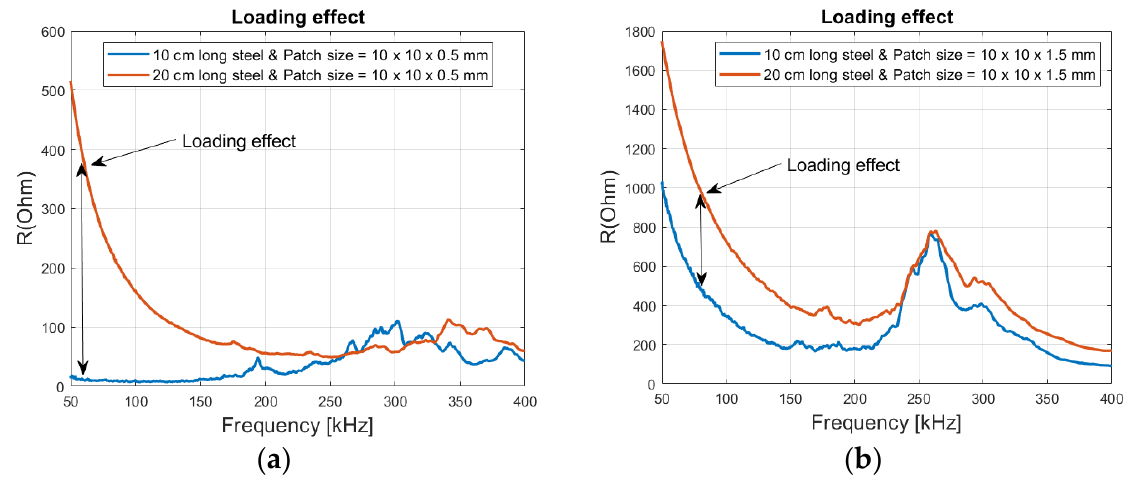
Figure 15. Loading effect from 10 and 20 cm long steel rod embedded inside concrete ( a ) Patch size of 10 × 10 × 0.5 mm and ( b ) Patch size of 10 × 10 × 1.5 mm.